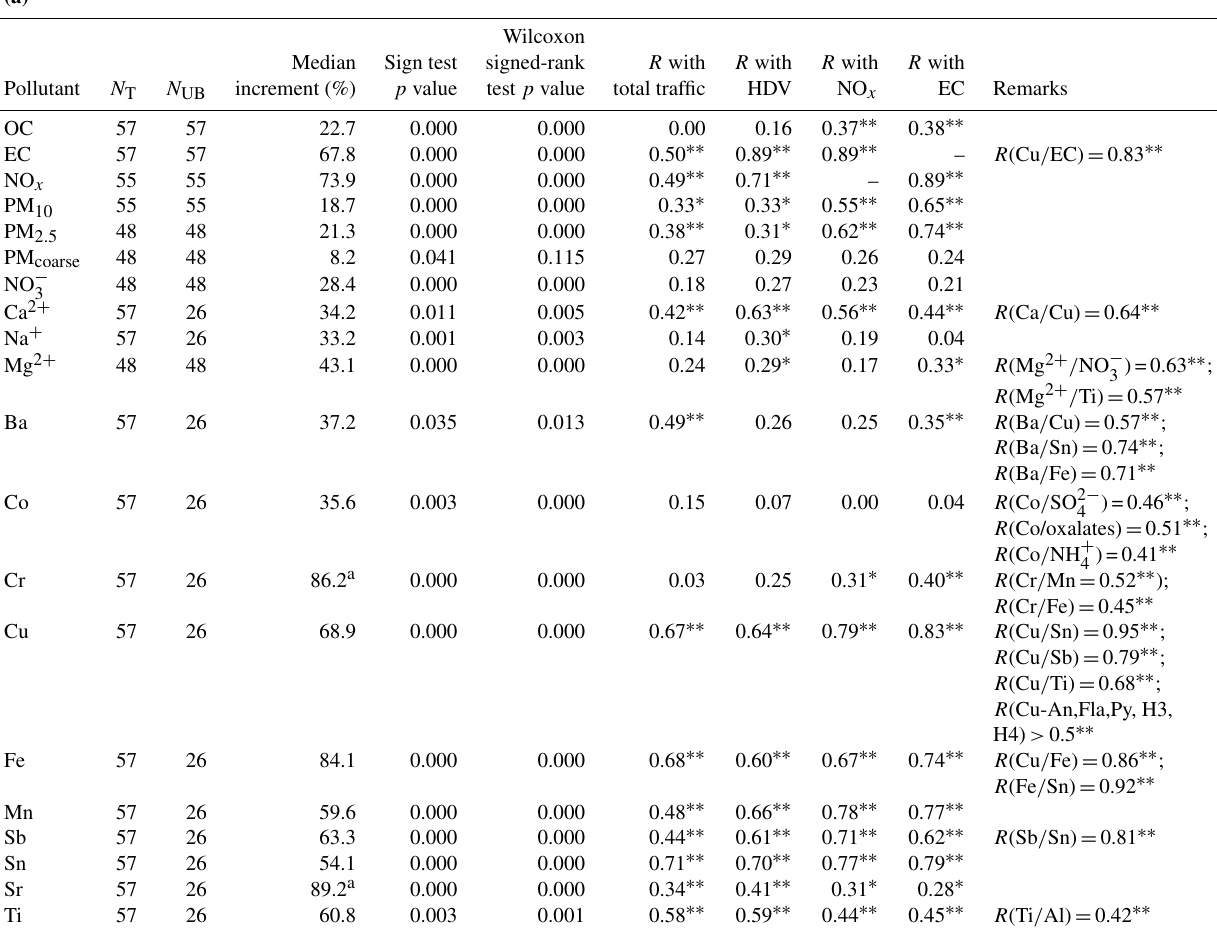
Table 1. (a) Median increments to concentrations measured near the RN87 highway in comparison to those measured in the urban background site (given in % of total concentrations) for species for which concentrations are significantly higher at the near-traffic site according to the sign and Wilcoxon signed-rank tests ( p < 0 . 05). PM coarse (difference between PM 10 and PM 2 . 5 ) is also included in this table. R represents the Spearman correlation coefficients with traffic, heavy-duty traffic (HDV), nitrogen oxides (NO x ) and elemental carbon (EC). N T is the number of samples collected at the traffic site (Echirolles), and N UB is the number of samples collected at the urban background site (Les Frênes site). (b) Median increments to concentrations measured near the RN87 highway in comparison to the urban background site (given in % of total concentrations at the traffic site) for organic species for which concentrations are significantly higher at the traffic site according to the sign and Wilcoxon signed-rank tests ( p < 0 . 05). R represents the Spearman correlation coefficients with traffic, heavy-duty traffic (HDV), nitrogen oxides (NO x ) and elemental carbon (EC). N T is the number of samples collected at the traffic site (Echirolles), and N UB is the number of samples collected at the urban background site (Les Frênes